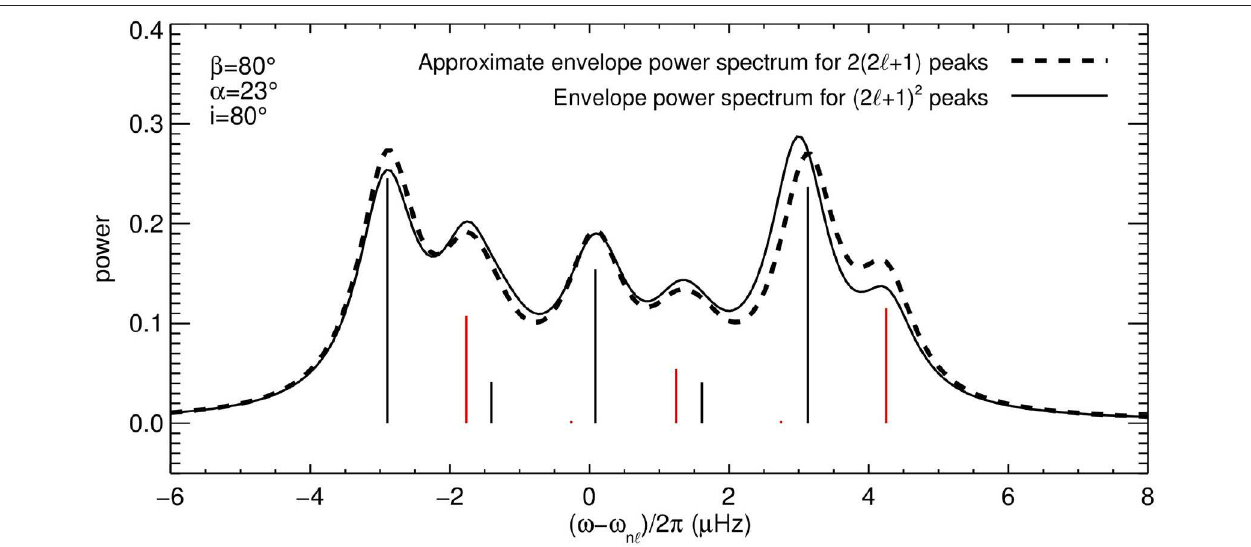
FIGURE 8 | Acoustic power spectrum for the same case as in Figure 4D , (black solid line) and the power spectrum resulting from neglecting differential rotation and by assuming a small rotation perturbation with respect to the AR perturbation (black dashed line), as calculated from Equations (50, 51, 54). Vertical red lines denote the M = 0 peaks, and black lines the averaged M 6= 0 peaks from Equations (55,